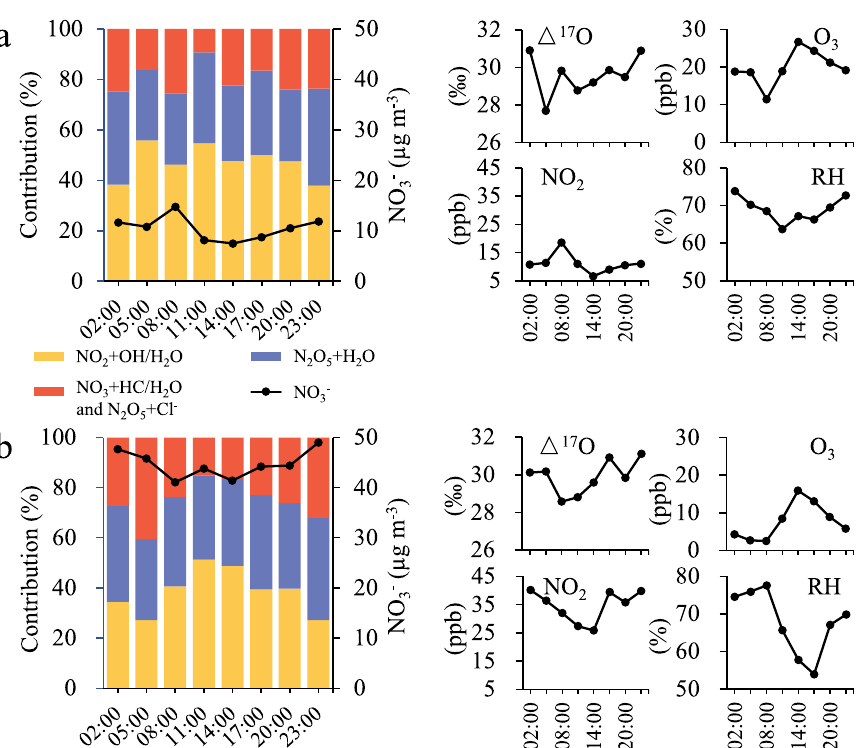
Fig. 5 Diurnal variations of nitrate formation pathways during clean and haze periods. The changes in mass concentrations of nitrate ), the relative contributions of three pathways (pathway 1: NO 2 + OH/H 2 O, pathway 2: N 2 O 5 + H 2 O and pathway 3: NO 3 + HC/H 2 O and ( NO (cid:1) 3 N 2 O 5 + Cl − ) to nitrate production, oxygen isotope anomaly of nitrate ( Δ 17 O( NO (cid:1) (RH) a during clean period and b during haze